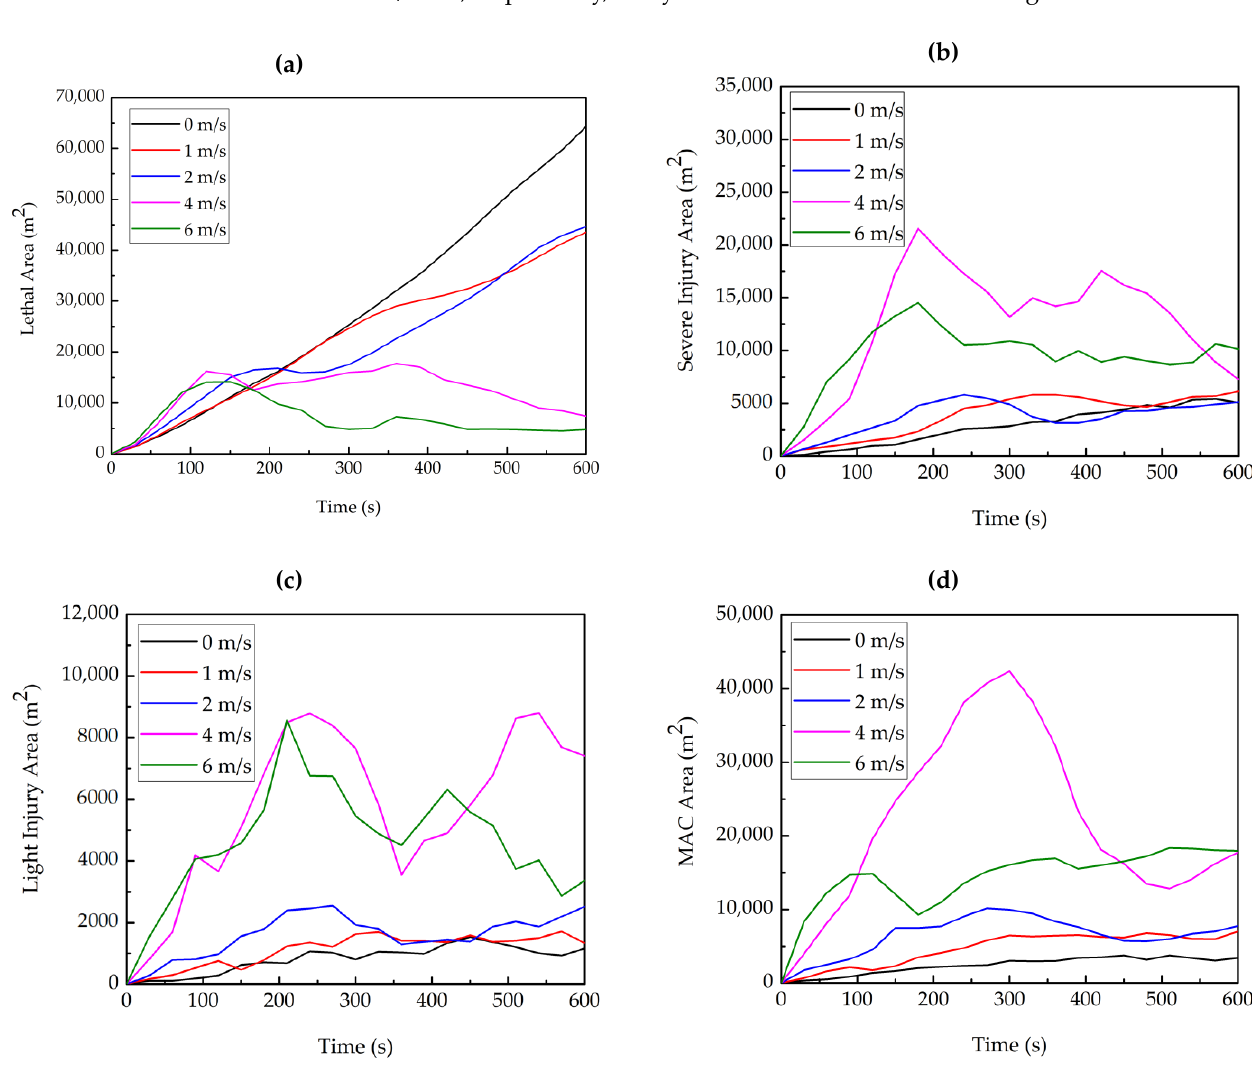
Figure 5. Changes in hazardous areas with time under different wind speeds at a height of 1.8 m: ( a ) lethal area; ( b ) severe injury area; ( c ) light injury area; ( d ) maximum allowable concentration area (MAC area).